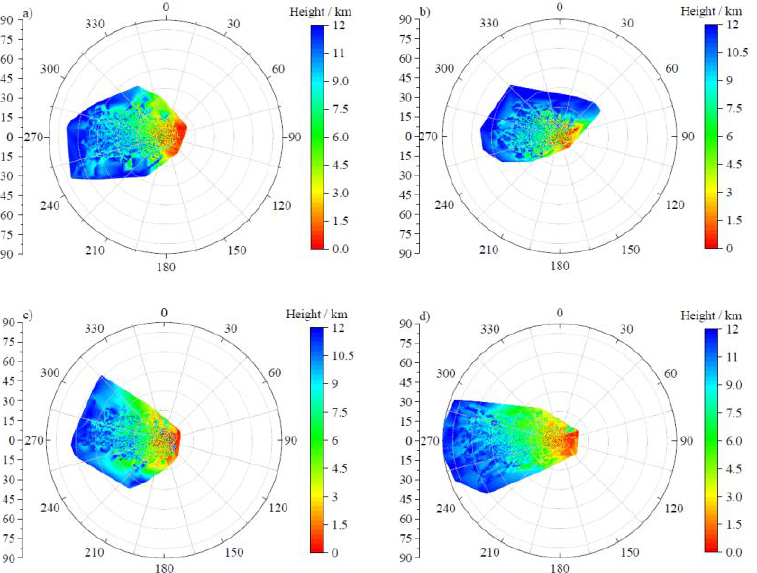
Figure 16. Seasonal variation characteristics of the wind speed and direction in the rising trajectory of the radiosonde. ( a ) Spring, ( b ) summer, ( c ) autumn, and ( d ) winter (0°: north, N; 90°: east, E; 180°: south, S; 270°: west, W).